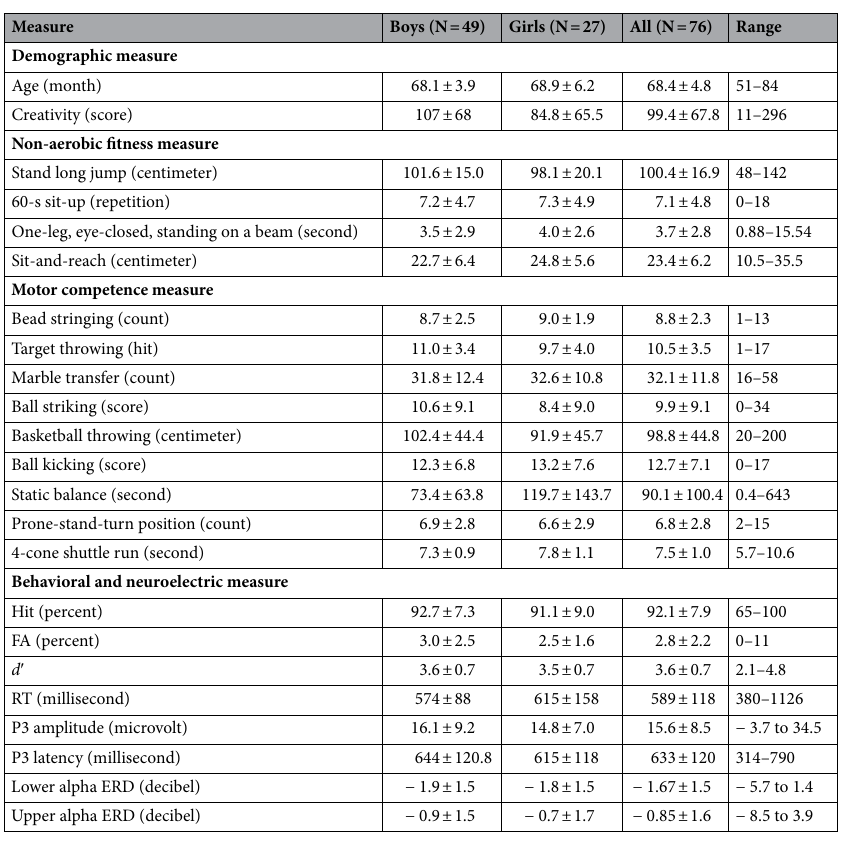
Table 1. The mean and standard deviation of demographic, non-aerobic fitness, motor competence, and behavioral and neuroelectric measures. The creativity scores were calculated based only on 73 participants (see Supplement for more